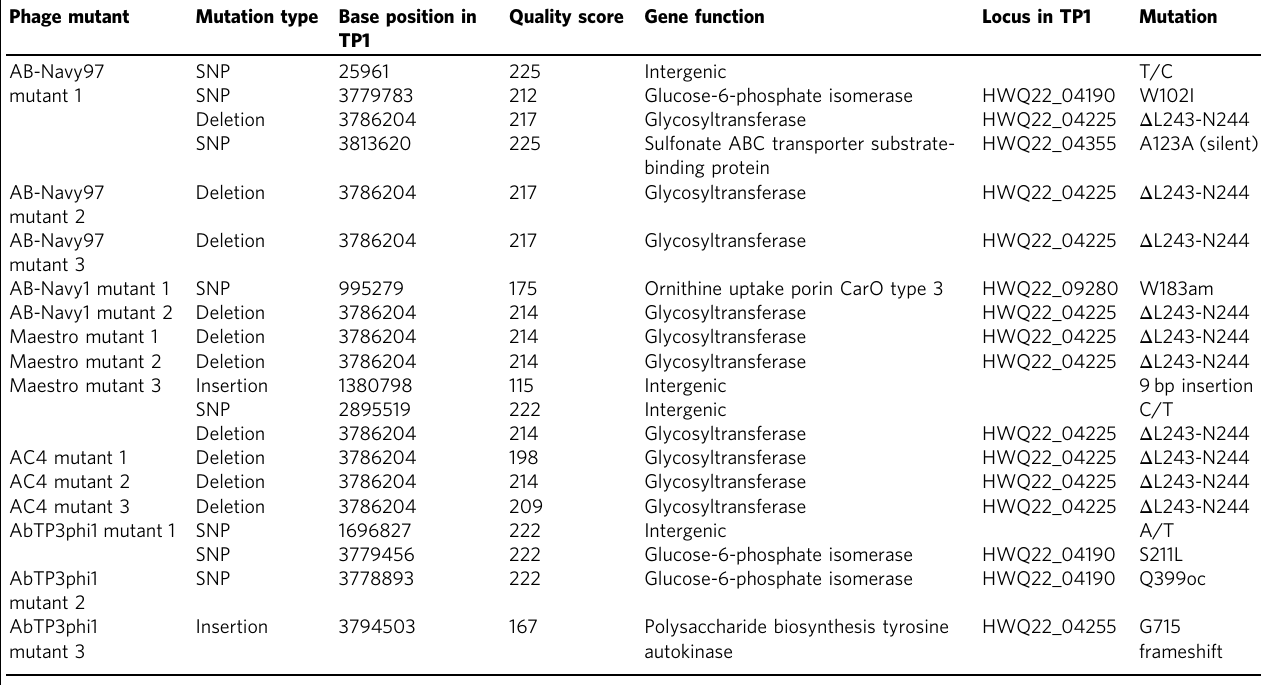
Table 4 Genetic changes identi fi ed in phage-resistant mutants of A. baumannii TP1 generated in vitro. Phage